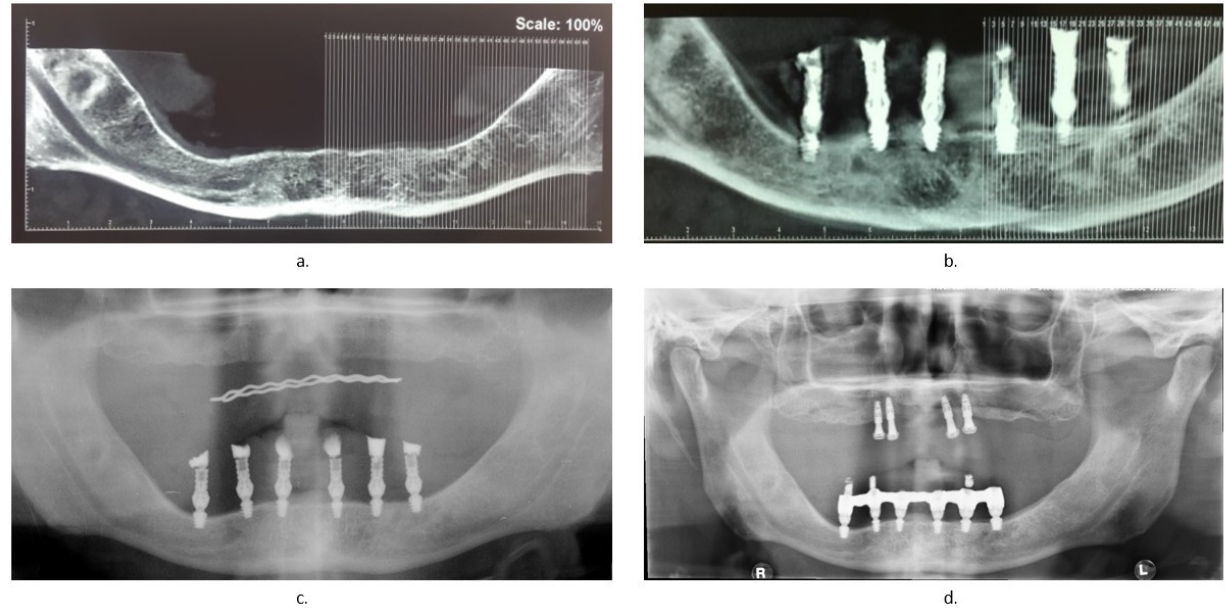
Figure 4. Radiographic checks: ( a ) cone beam before surgery; ( b ) cone beam 4 months after surgery; ( c ) OPG (Orthopantomography)1 year later; ( d ) OPG 3 years later.